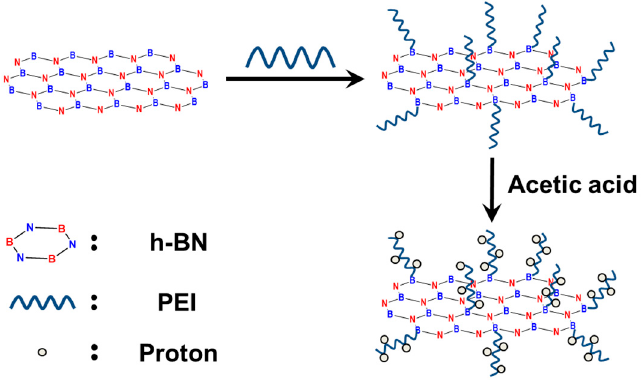
Figure 3. Synthesis scheme of the h-BN/PEI particles.